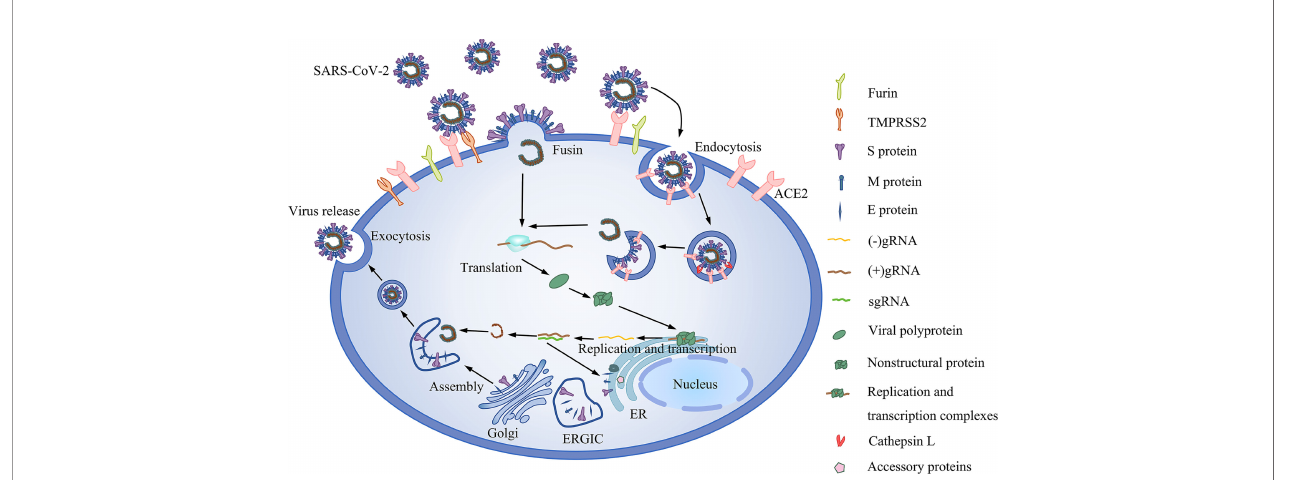
FIGURE 2 | The life cycle of SARS-CoV-2. It includes viral entry, replication and transcription, assembly and release. Binding of SARS-CoV-2 to the ACE2 receptor and the subsequent activation of the virus by Furin and TMPRSS2. In the absence of TMPRSS2, the virus is activated by intracellular cathepsin. Upon entry into the cell, ORF1ab of the virus is translated to polyproteins, which are then cleaved into nonstructural proteins before assembly into replication and transcription complexes. Replication and transcription of the genome generate gRNA and subgenomic RNA (sgRNA). Shorter sgRNAs encode structural proteins and accessory proteins. The ERGIC is then assembled into mature SARS-CoV-2